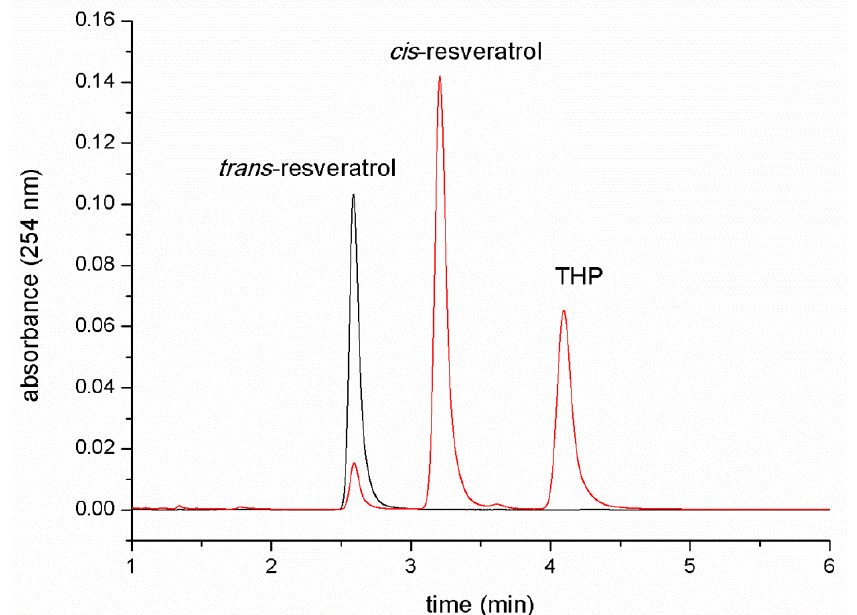
Figure 3. Chromatographic separation of resveratrol isomers and THP before (black chromatogram) and after (red chromatogram) sunlight exposure of a 10 mg/mL solution of the trans -isomer in DMSO for 1 h. Retention times were 2.6 min for trans -resveratrol, 3.2 min for cis -resveratrol and 4.1 min for THP.